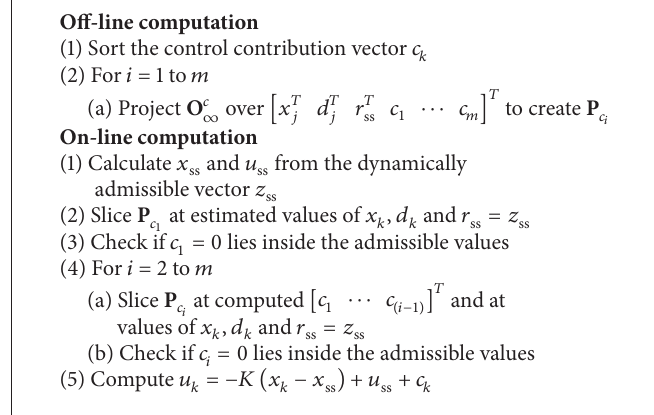
Algorithm 3: Control calculation.